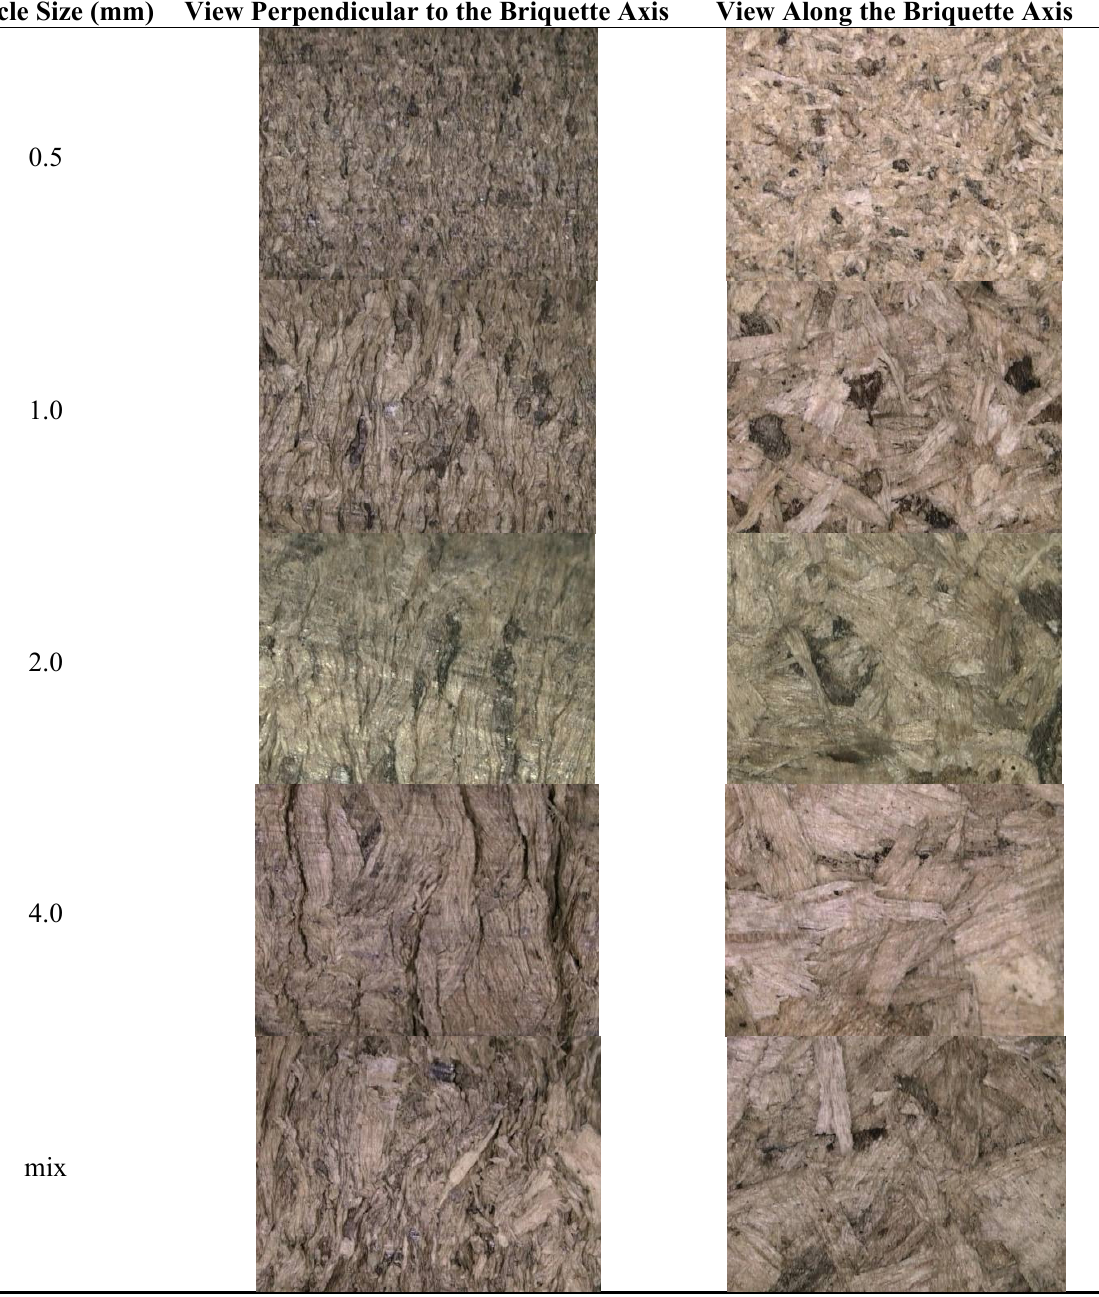
Figure 16. Briquettes from beech sawdust with different pressures applied ( w r = 8%; T = 25 °C). Table 1. Zoom views of the investigated briquette surfaces using a digital microscope (40×). Particle Size